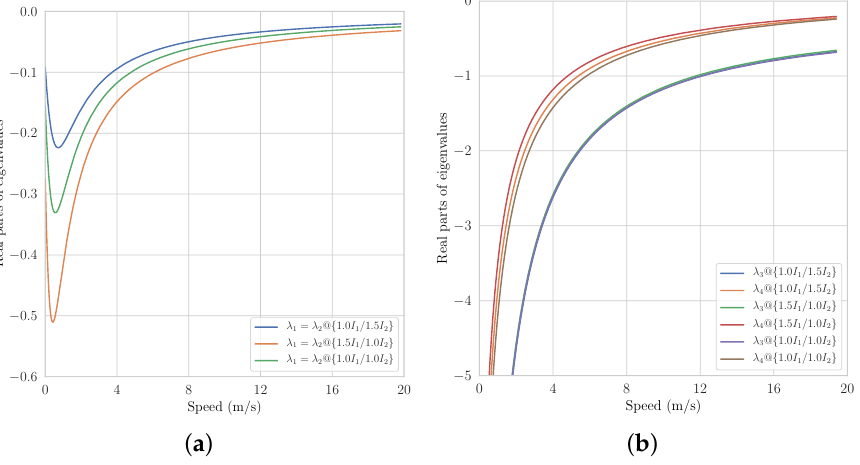
Figure 9. Variation of the real parts of the eigenvalues with the moment of inertia: ( a ) real parts of λ 1 and λ 2 and ( b ) real parts of λ 3 and λ 4 .